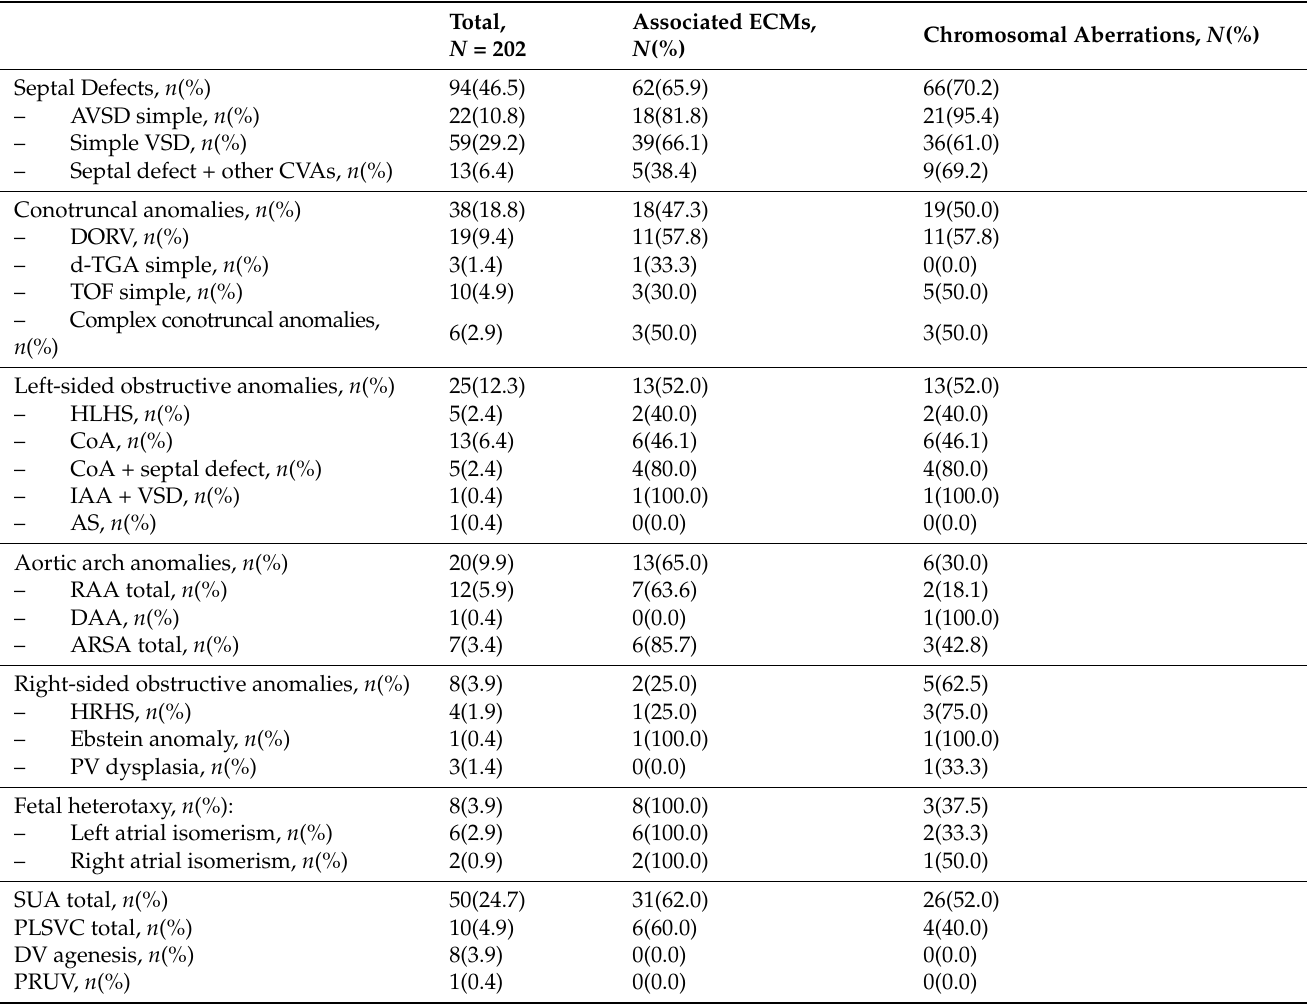
Table 1. Diagnostic types of cardiovascular anomalies detected among 1005 pregnant women referred for invasive prenatal testing. Total, Associated N = 202